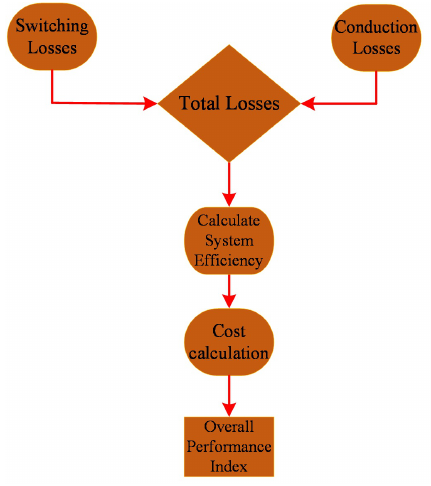
Figure 18. Performance evaluation chart.